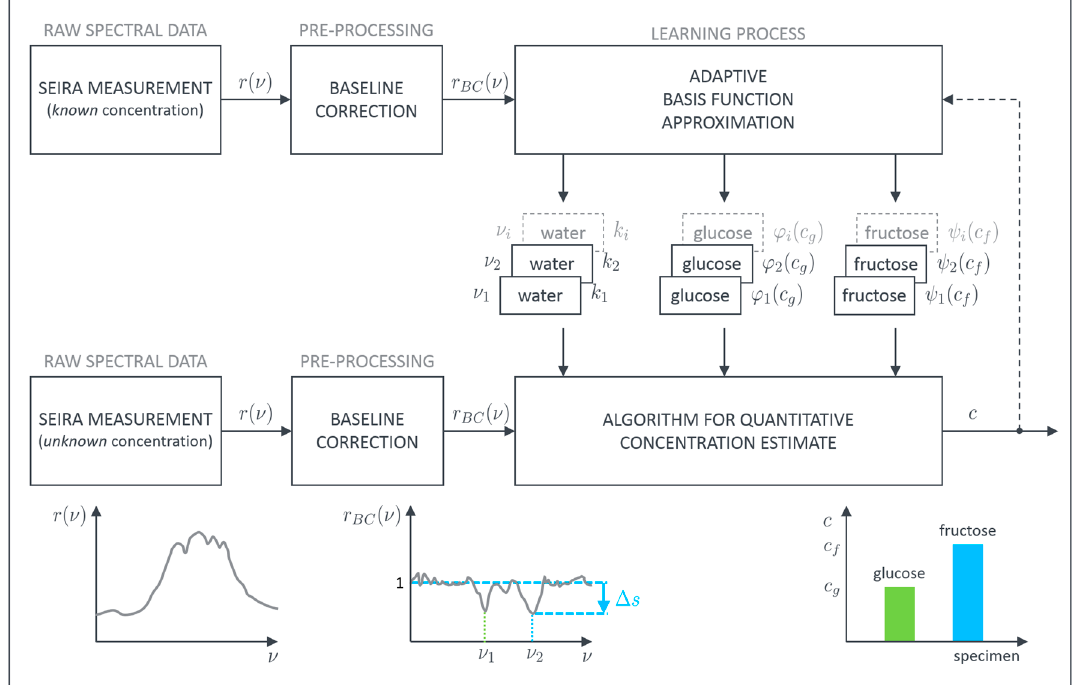
Figure 2. Schematic description of the developed adaptive process for evaluation of surface enhanced infrared absorption (SEIRA) measurement data to quantitatively estimate glucose and fructose concentrations in aqueous solutions.